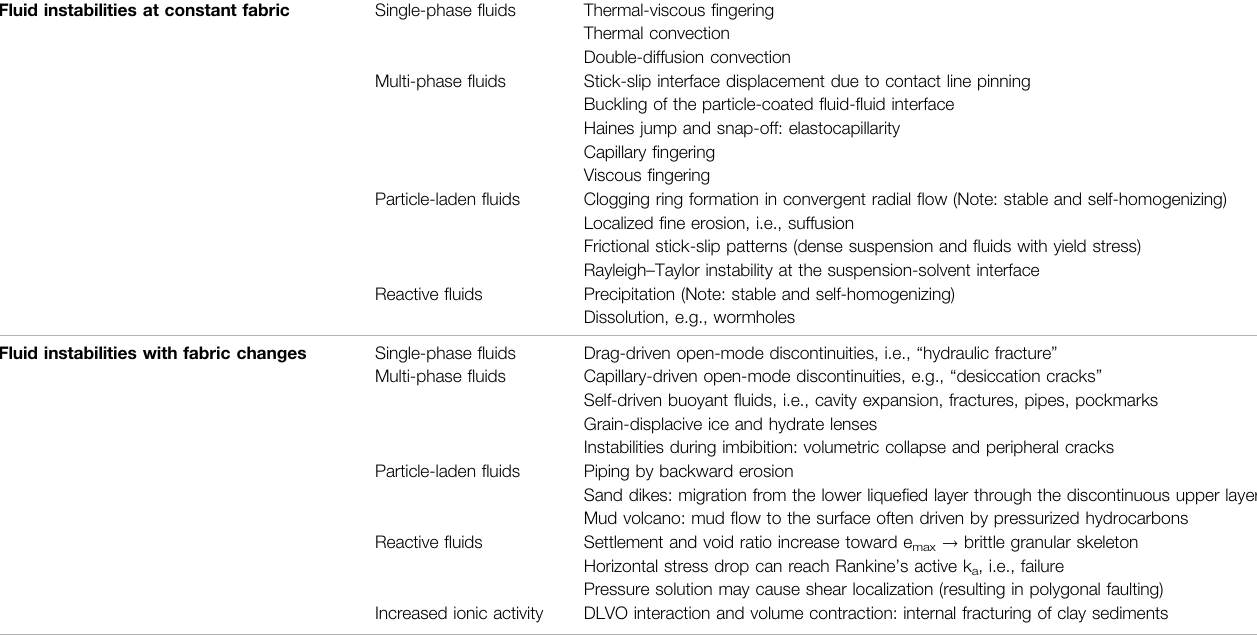
TABLE 1 | Fluid-driven instabilities in granular materials. Examples are organized into instabilities 1) at constant fabric and 2) with fabric changes. Fluid instabilities at constant